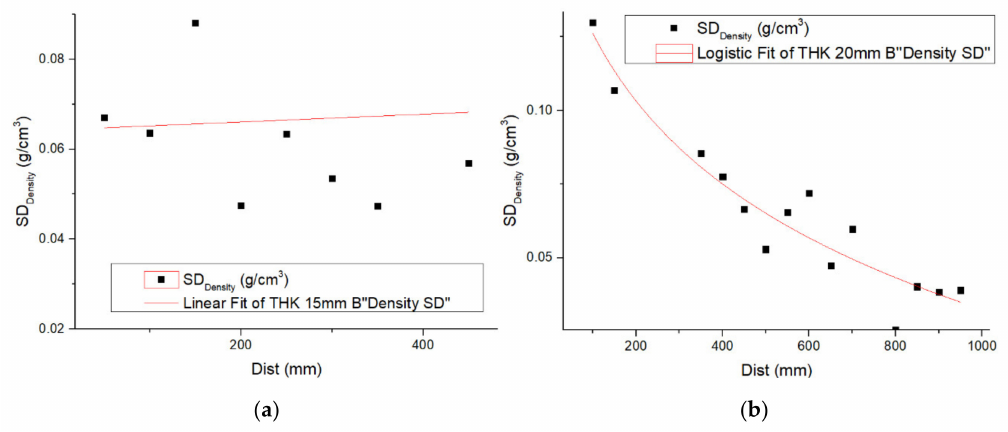
Figure 10. Change in SD of with distance from centerlines to edges for 20-mm panel. ( a ) With direction, ( b ) Length